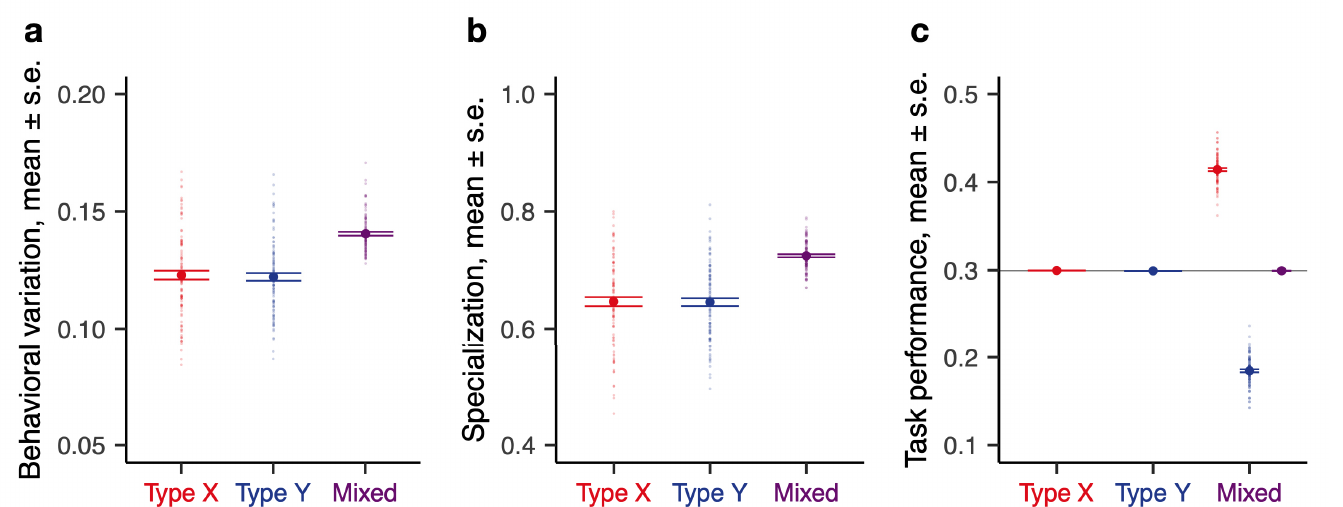
Fig 1. Baseline theoretical predictions. Division of labor (DOL, measured by colony-level behavioral variation ( a ), colony-level specialization ( b )) and task performance frequency for a single task ( c ) shown as a function of colony composition. Opaque circles represent individual replicate colonies ( n = 100 replicates for each composition); solid circles represent the average value across replicates; horizontal lines represent s.e.; and the horizontal gray line in ( c ) represents the average of the pure colonies (first 2 columns). Types X and Y differ in mean threshold: μ X = 10, μ Y = 20; all other parameters are identical across types (see S1 Table). Simulation code and data are available at https://github.com/marikawakatsu/mixing-model. DOL, division of labor.